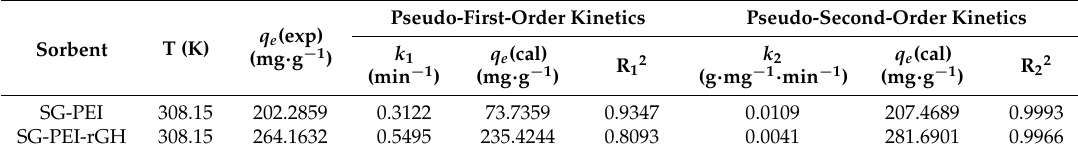
Table 3. Kinetic parameter of the adsorption of Hg 2+ onto SG-PEI and SG-PEI-rGH adsorbents.